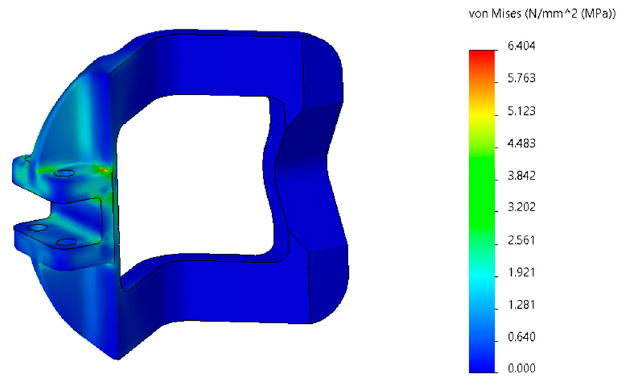
Figure 25. Force analysis of grasping claw.